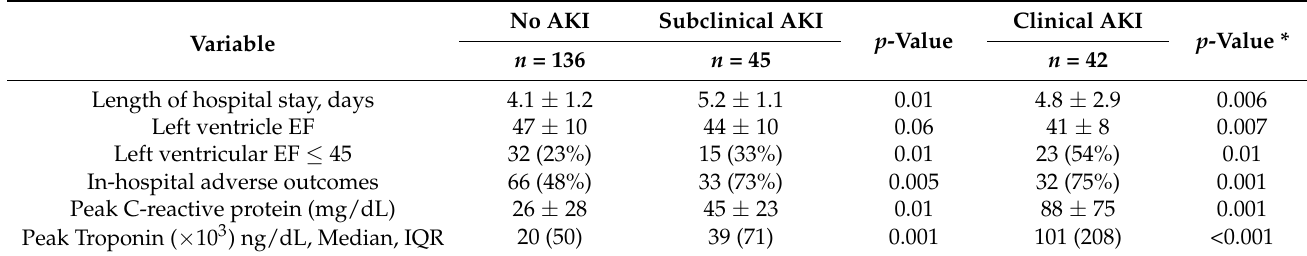
Table 2. In-hospital outcomes for 223 STEMI patients according to AKI occurrence.